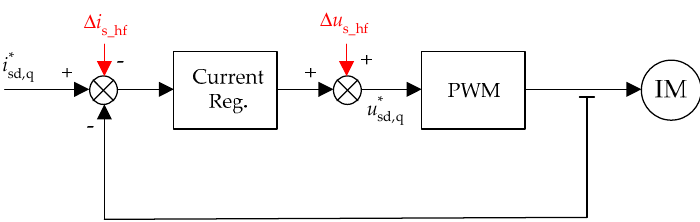
Figure 9. Simplified diagram of the high frequency AC voltage injection for online parameter identification.